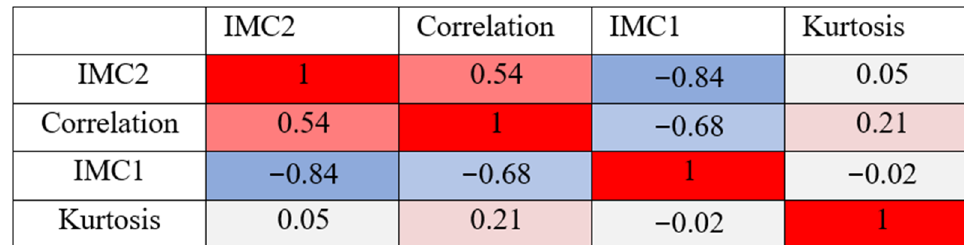
Figure 4. The Spearman rank-order correlation coefficient between the four radiomics features used in the multivariate predictive model. It varies between − 1 and +1 with 0 implying no correlation. Correlations of − 1 or +1 imply an exact monotonic relationship. Positive correlations imply that as one feature increases, so does the other feature, whereas negative correlations imply that as one feature increases, the other decreases. White—no correlation, Red—positive correlation, Blue—negative correlation.